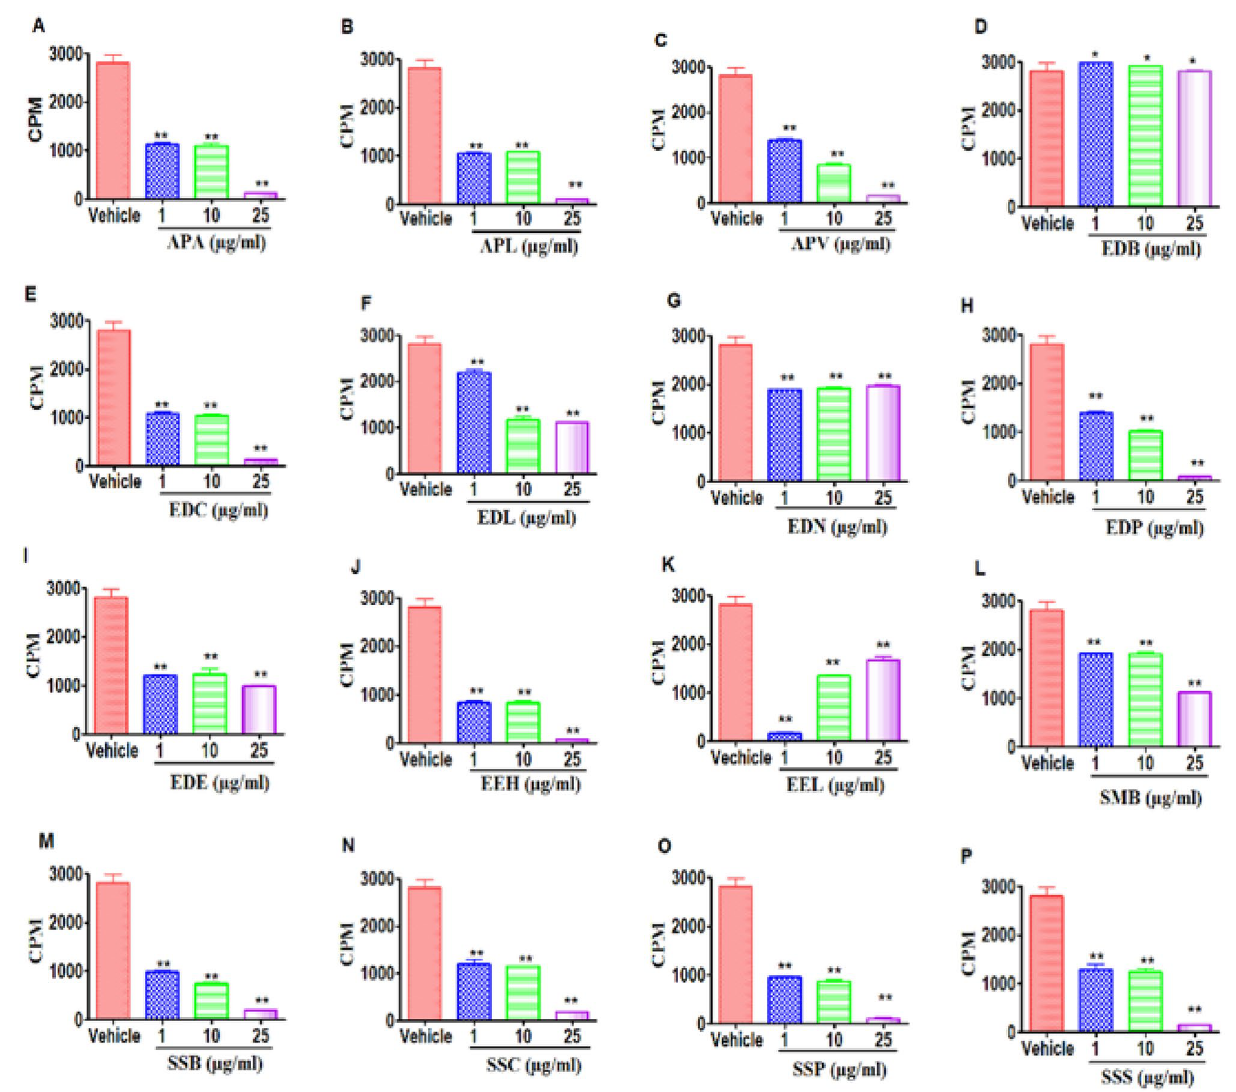
Figure 11. Effect of APL treatment on Proliferation of B cells: This was determined by 3 H-Thymidine incorporation after 24 h treatment with plant extracts or vehicle, DMSO. ( A – C ) represent the Asteraceae family (( A ) APA, ( B ) APL, ( C ) APV). ( D – I ) represent the Ebenaceae family (( D ) EDB, ( E ) EDC, ( F ) EDL, ( G ) EDN, ( H ) EDP, ( I ) EDE). ( J , K ) represent the Erythroxylaceae family (( J ) EEH, ( K ) EEL). ( L – P ) represent the Sapotaceae family (( L ) SMB, ( M ) SSB, ( N ) SSC, ( O ) SSP, ( P ) SSS). The vertical bars represent mean ± S.E.M. of triplicate cultures and data were expressed as counts per minute (CPM). The significance between various groups was tested using one-way ANOVA where NS: Not significant; (*)p < 0.05, (**)p < 0.01, (***)p <